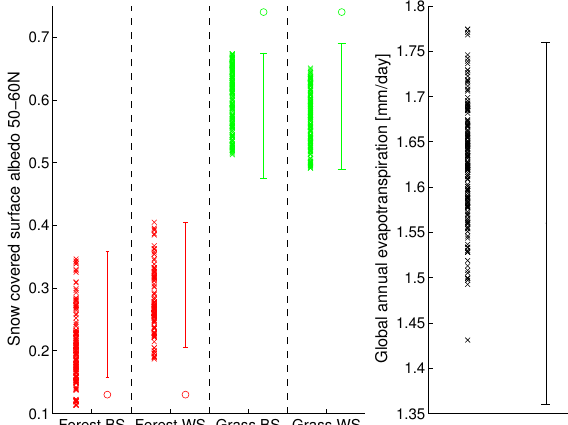
Fig. 2. (a) Comparison of the clear-sky (BS) and cloudy-sky (WS) albedo of snow covered forest and grass for all the ensemble mem- bers (crosses) with data from MODIS (error bar) (Jin et al., 2002; Moody et al., 2007). Circles indicate the albedo values from site observations (Betts and Ball, 1997). (b) Comparison of the mean annual evapotranspiration rate over land for all the ensemble mem- bers (crosses) and the reference data from (Mueller et al., 2011) (error